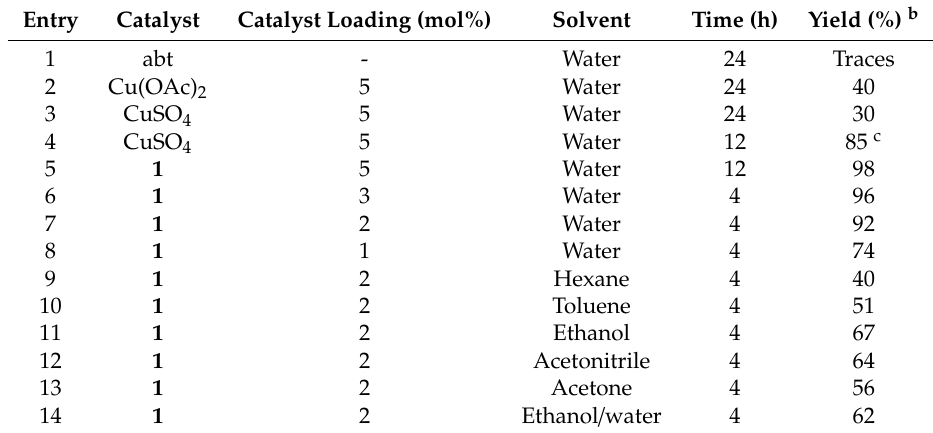
Table 2. Optimization of reaction conditions for complex 1 -mediated benzyl azide-phenylacetylene cycloaddition a .